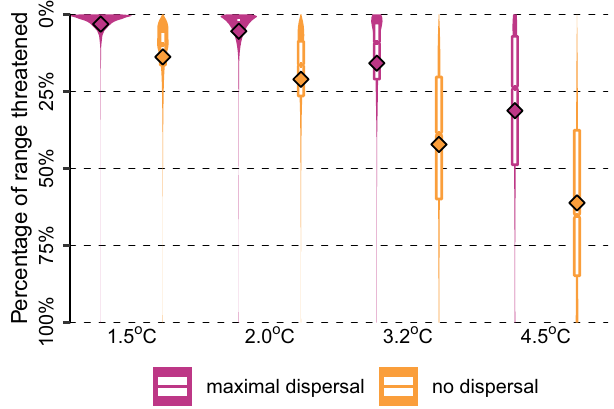
Fig. 1 Proportion of geographic range threatened at different global warming levels. The violin plots show the proportion of geographic range threatened by future climate extremes for 11,425 freshwater fi sh species, different warming levels and two dispersal assumptions. For each species and warming level, the mean across the different scenarios (GCM – RCP combinations) is calculated. Within each violin, the white boxes show the interquartile range as well as the median, while diamonds represent the mean. Source data are provided as a Supplementary Data